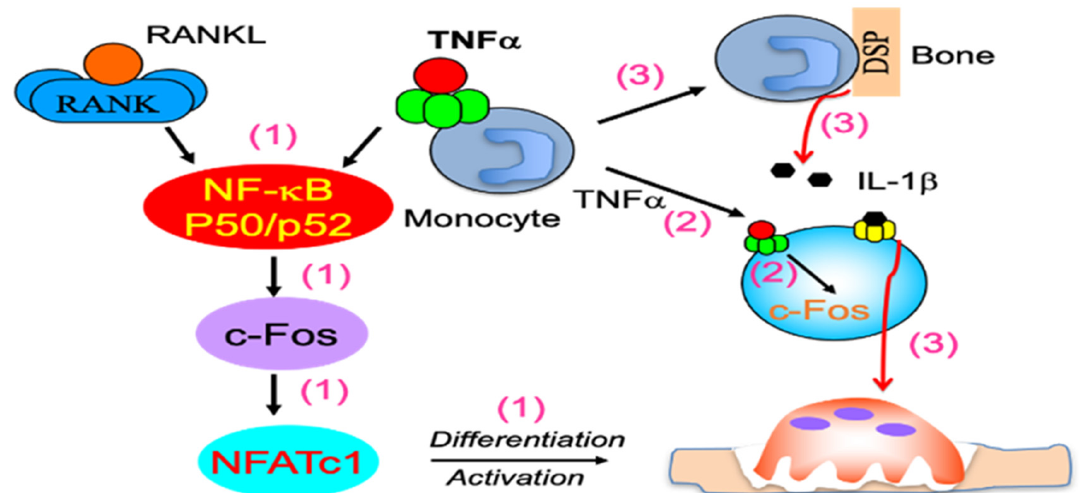
Figure 1. Key factors that mediate TNF-induced OC differentiation. (1) Similar to, and independent of, RANKL, TNF α sequentially activates NF- κ B p50 and p52, then c-Fos, followed by NFATc1 to induce OC differentiation; (2) TNF α pre-activated OCPs expressing c-Fos attach to bone, and (3) are stimulated by bone matrix proteins, such as dentin sialoprotein (DSP), to produce IL-1 β , which me-